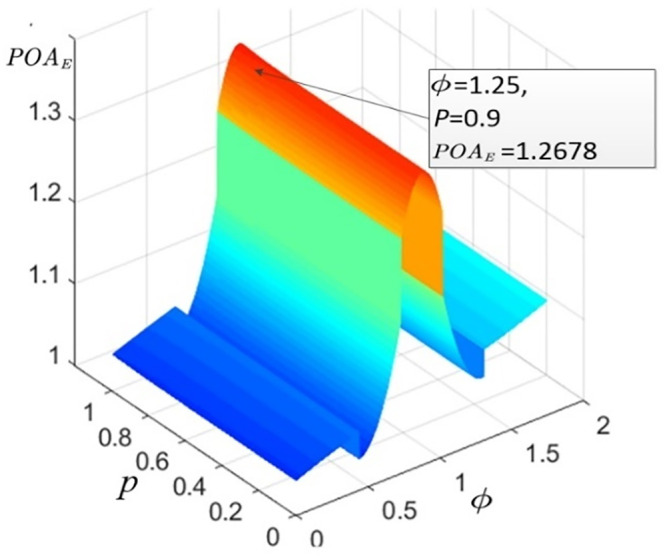
P-Φ-POAE surface graph.